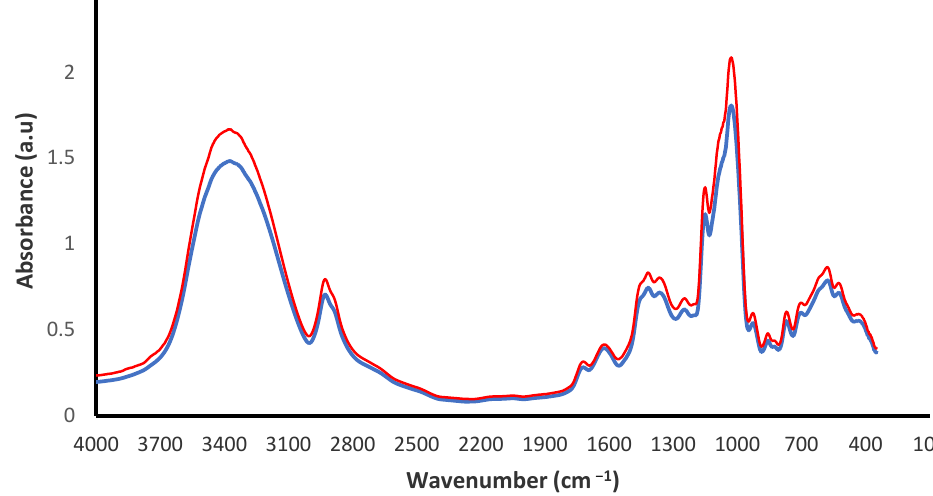
Figure 4. FTIR spectra profiles for beverage powders with MD-DE 10 (red lines) and MD-DE 15 (blue lines) samples.